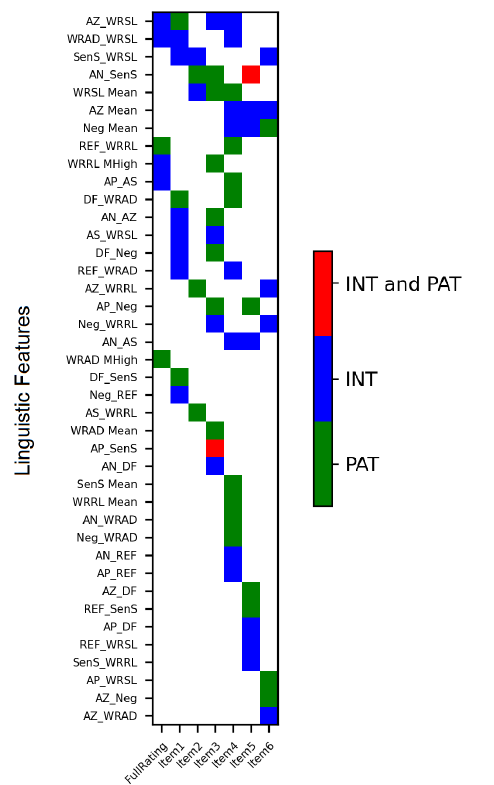
Figure 6. The best linguistic features are represented on the horizontal axis, for predicting the full competency rating or each rating item represented on the vertical axis. The rating item numbers are based on the numbers in Table 4. The green blocks indicate the selected features for the patient’s segments, the blue blocks indicate the selected features for the practitioner’s segments and the red blocks indicate the selected features for the full session, including the patient’s and practitioner’s